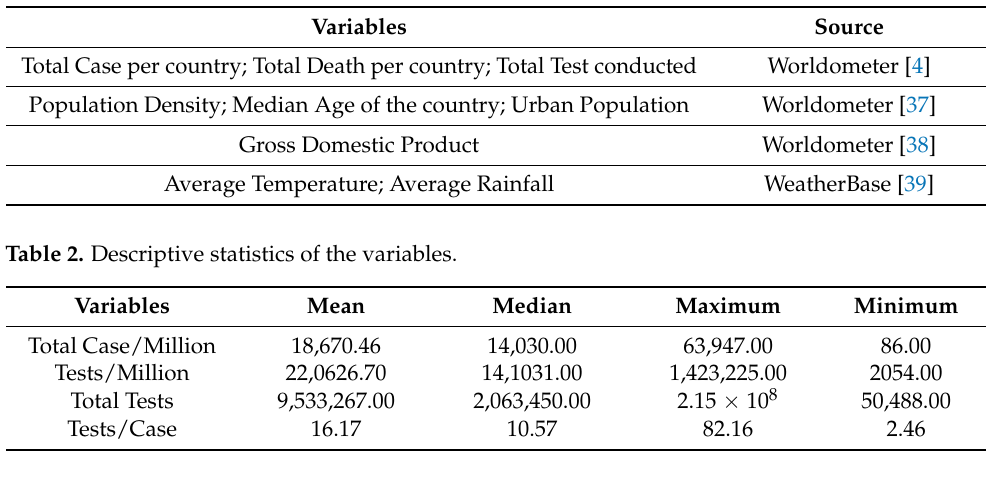
Table 1. Summary of data source.